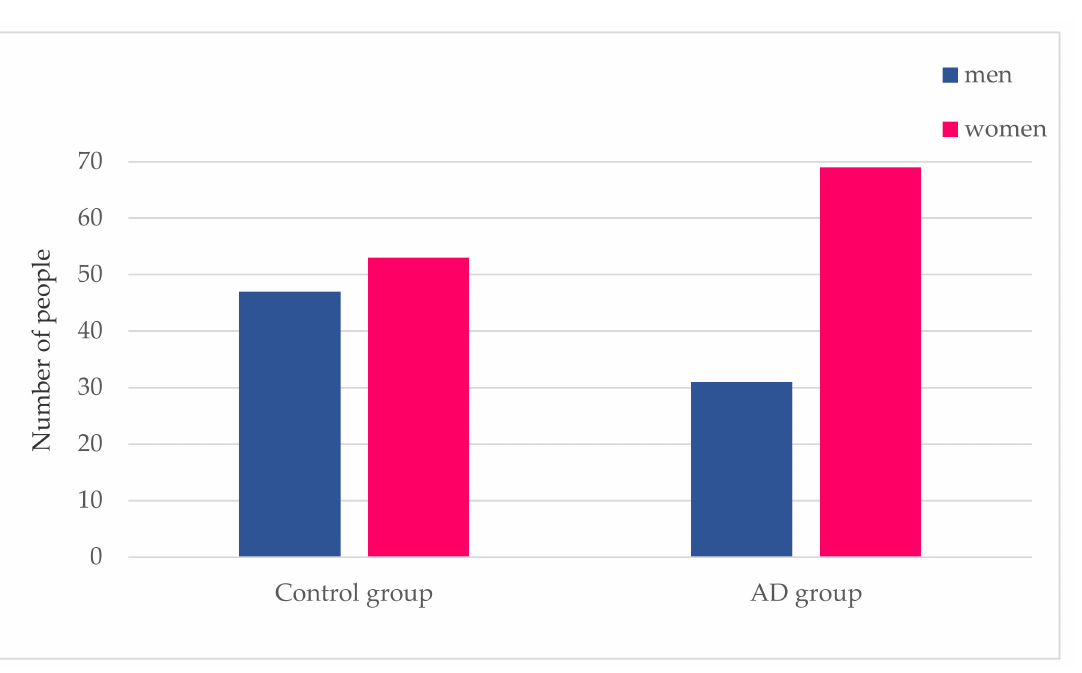
Figure 1. Alzheimer’s disease and gender. This figure shows the number of men and women that make up both the control group and the Alzheimer’s disease (AD)